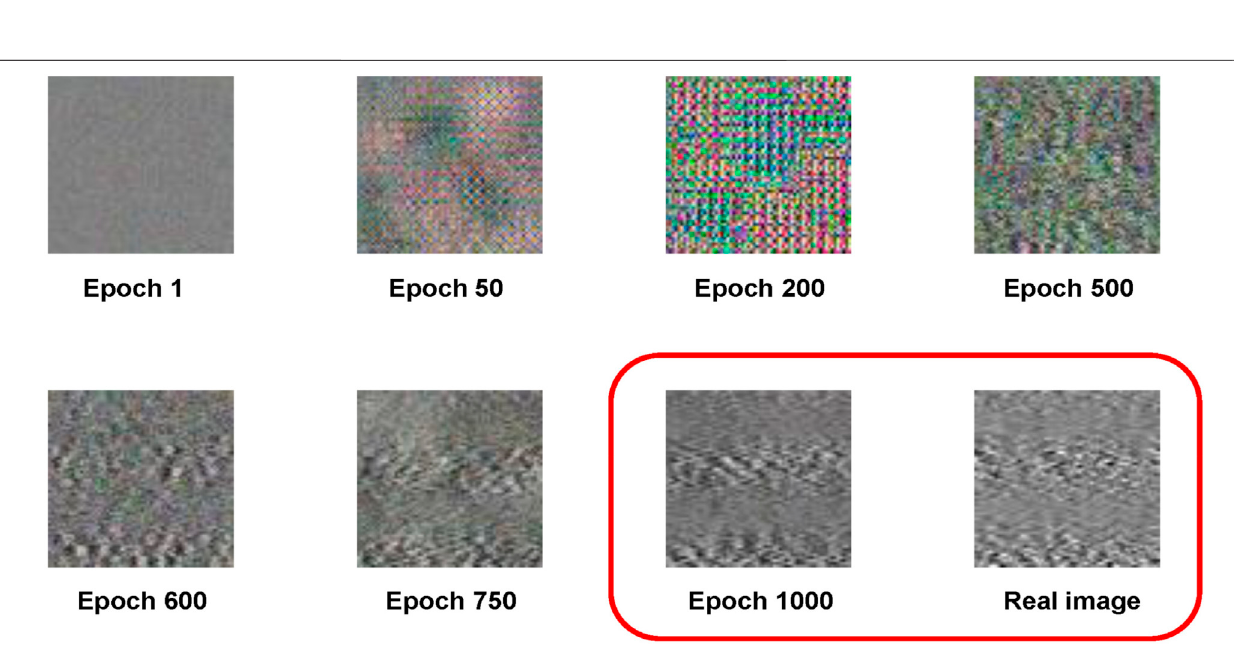
Figure 5 shows the synthetic EMG images generated by DCGAN at different epochs, in which the DCGAN is trained by the EMG data of a gesture. It can be found that with the increase of epoch, the quality of the image improves. In comparison with the real EMG image, the synthetic one shows a very similar appearance at 1000 epochs. Thus, the last 100 synthetic images at 901 – 1000 epochs are selected as the synthetic dataset.